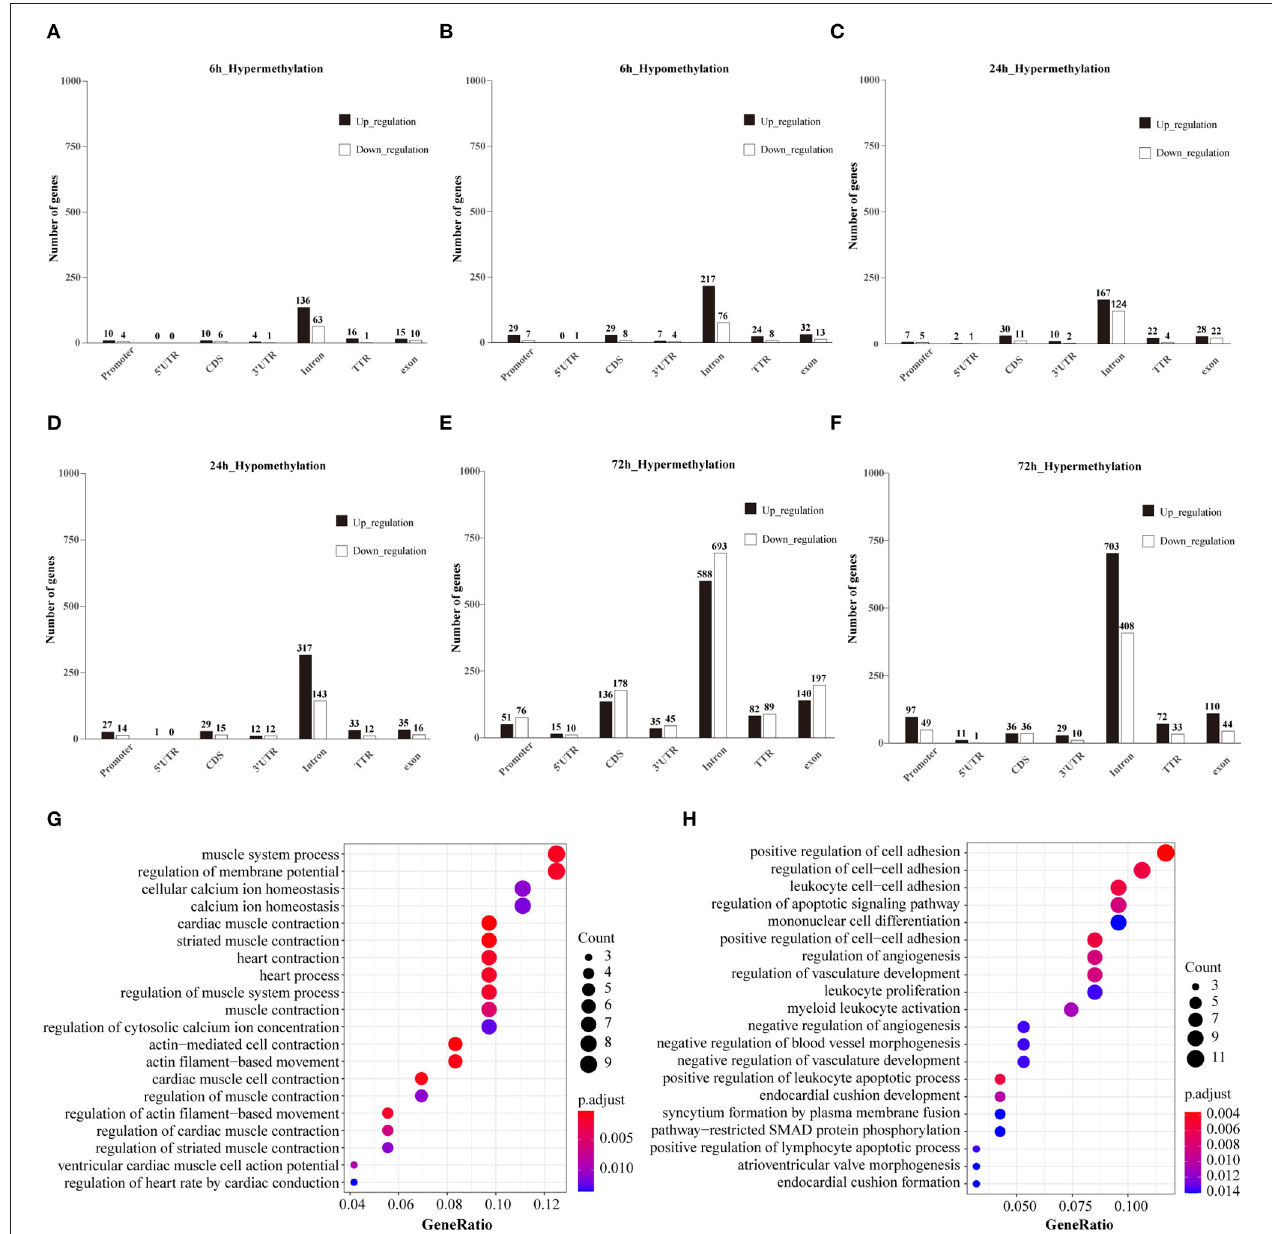
FIGURE 8 | (A–F) Bidirectional expression patterns of differentially hypermethylated genes in different genomic elements. The number of genes is given at the top of each graph bar. (G) Top 20 items for GO analysis of hypermethylated and down-regulated genes at 72h. (H) Top 20 items for GO analysis of hypomethylated and up-regulated genes at